Question: What kind of plot is shown here?
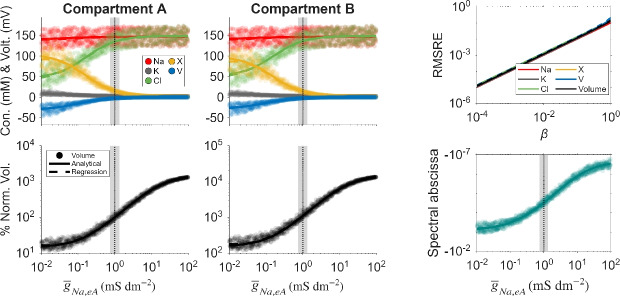
Answer: scatter